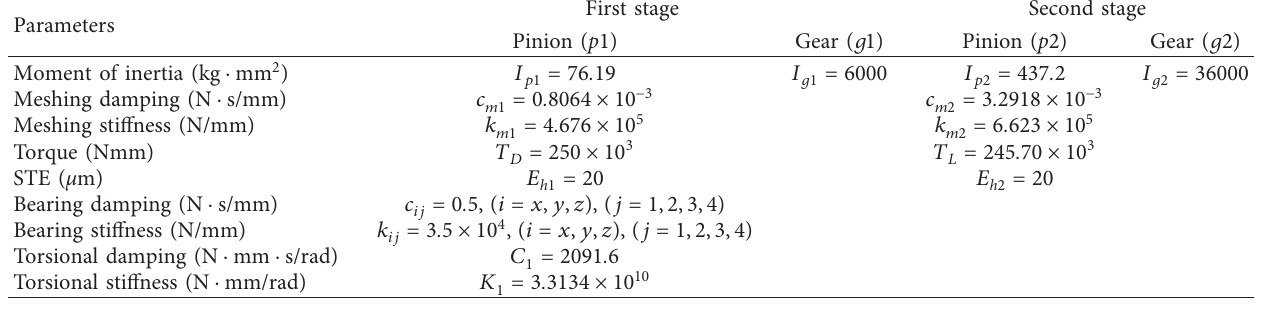
Table 2: The basic parameters of the TSHG reduction gear pairs.